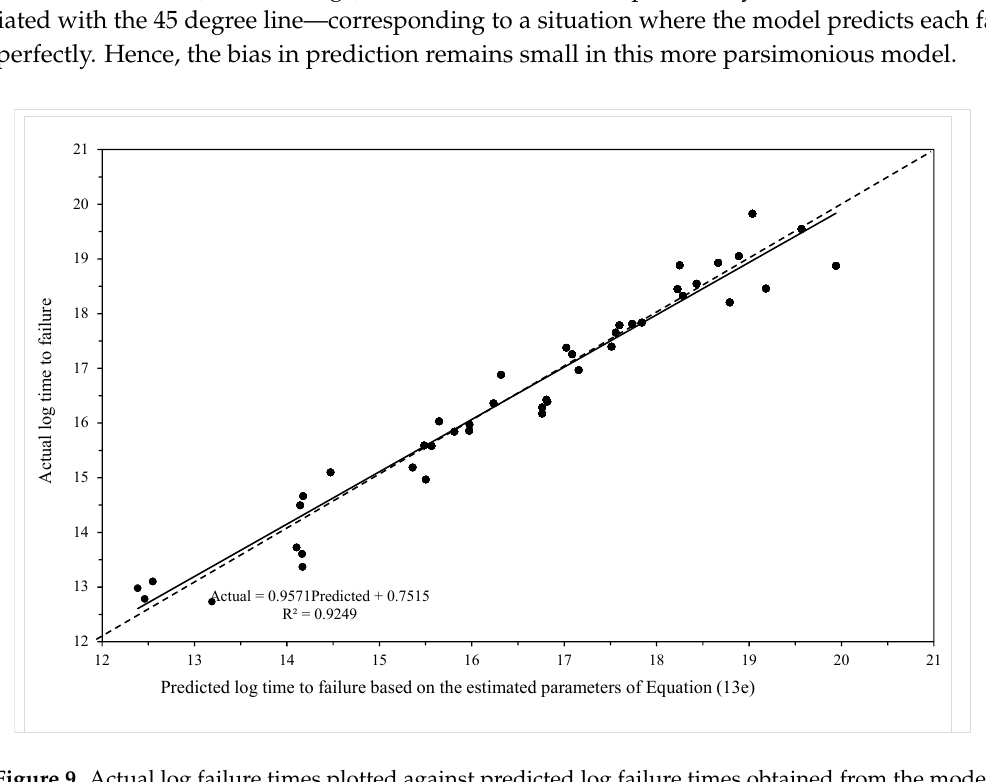
Figure 9. Actual log failure times plotted against predicted log failure times obtained from the model given by Equation (19f).